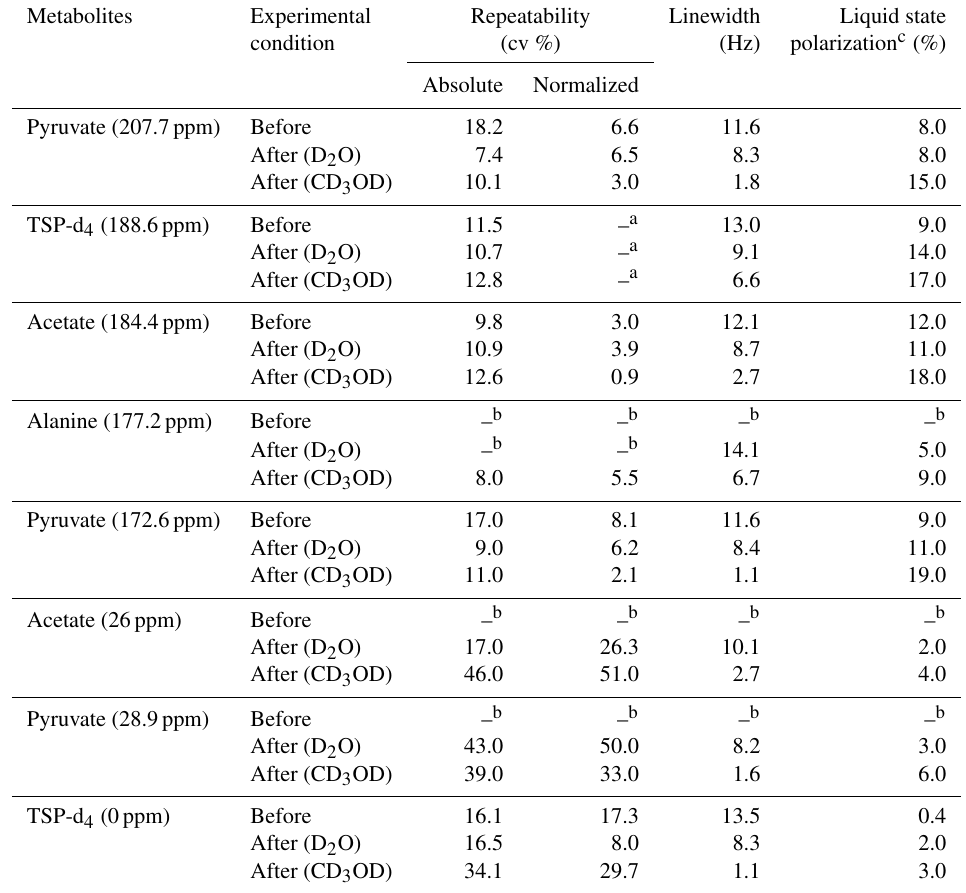
Table 3. Repeatability comparison of 13 C– { 1 H } signal integrals of metabolites with and without systematically optimized parameters and with two different dissolution